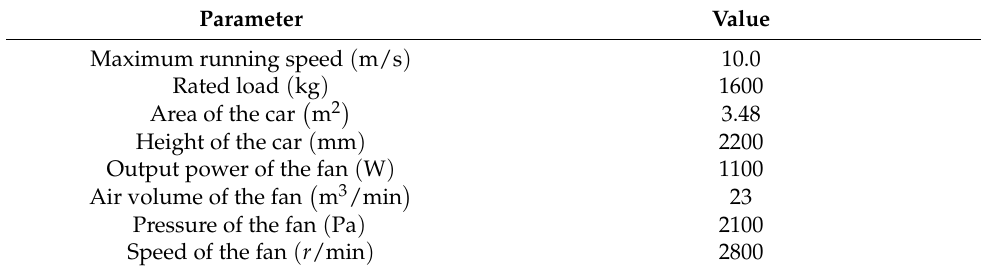
Table 3. Related parameters of the KLK2